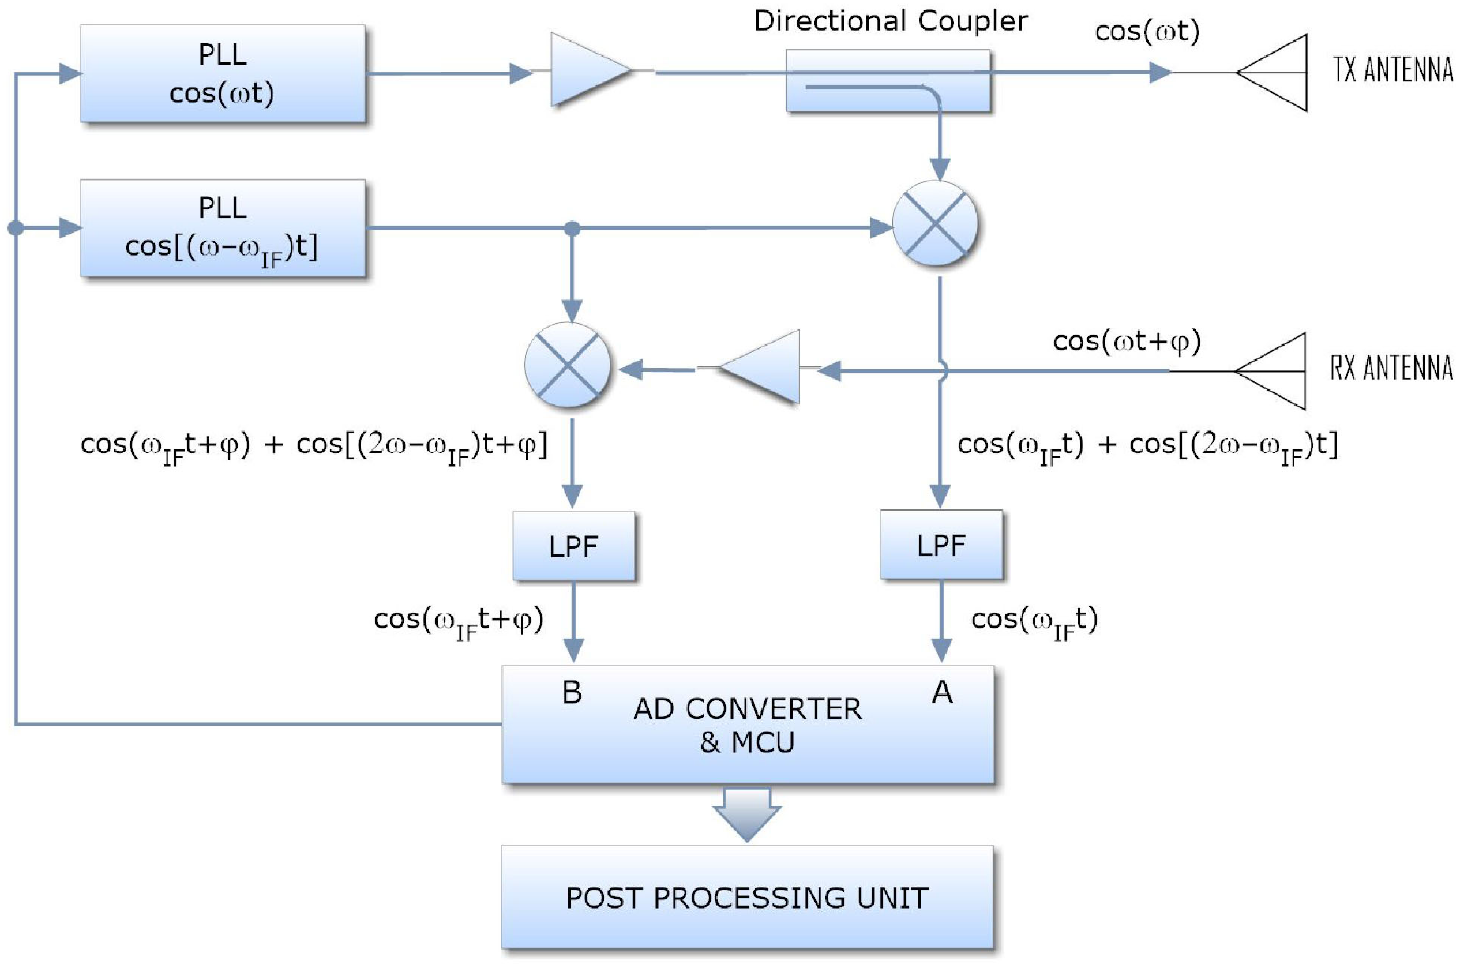
Figure 20. Block diagram of the prototype RX/TX unit for HDomo 2.0